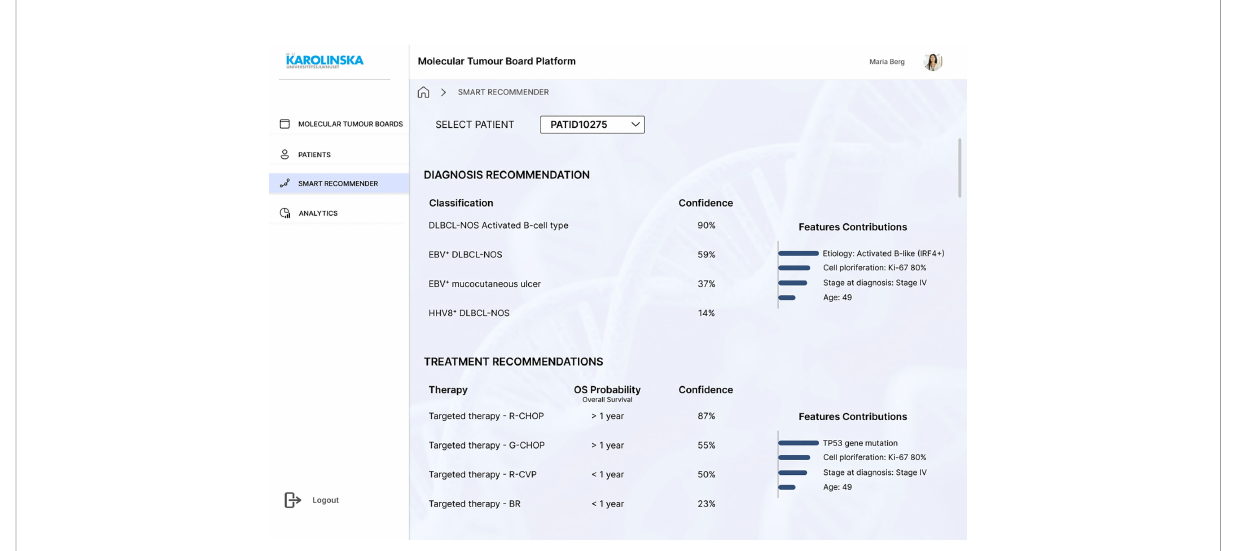
FIGURE 9 Mock-up screen. “ Smart Recommender ” giving recommendations for the patient case under